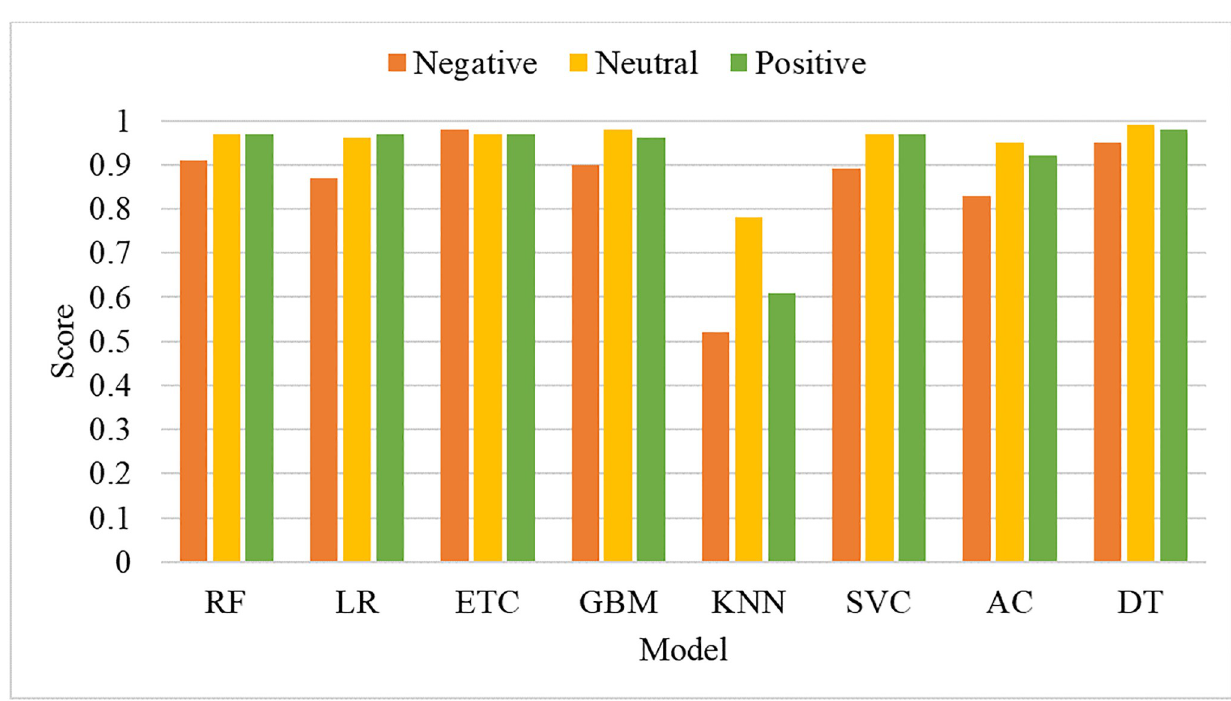
Fig 8. Performance analysis for individual class using BoW